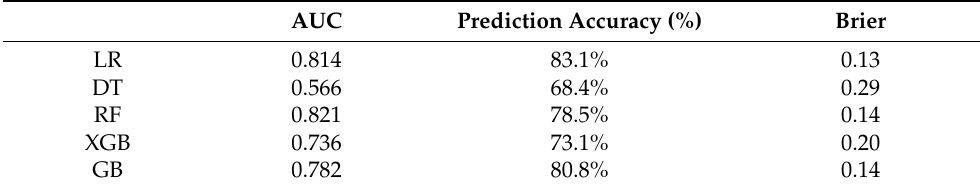
Table 2. The results of the machine learning analysis of the five machine learning algorithms for the posterior cases.